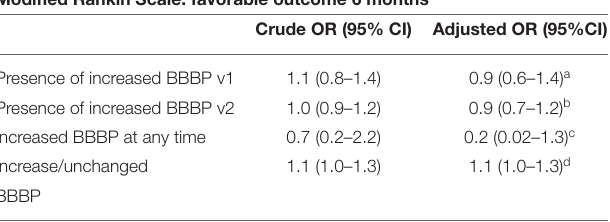
TABLE 7 | Multivariate regression analyses of increased BBBP before intervention and during follow up and favorable functional outcome (mRS <